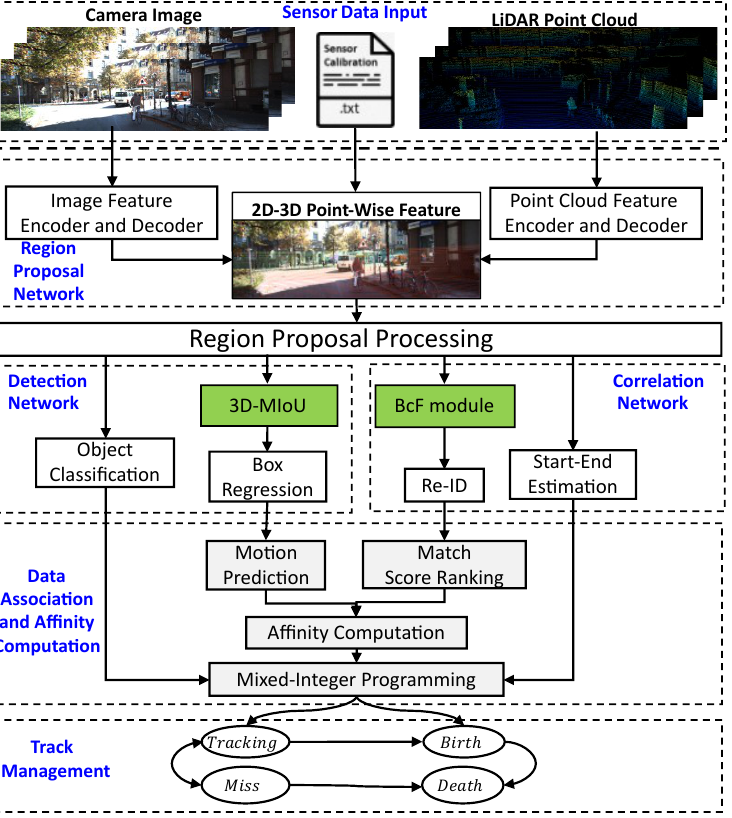
Figure 1. The system architecture of the proposed camera-LiDAR-based joint multi-object detection and tracking system.